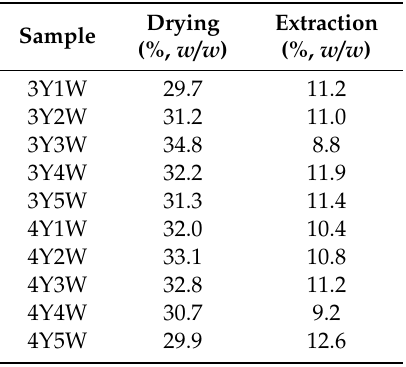
Table 2. Drying and extraction yields of ginseng berry